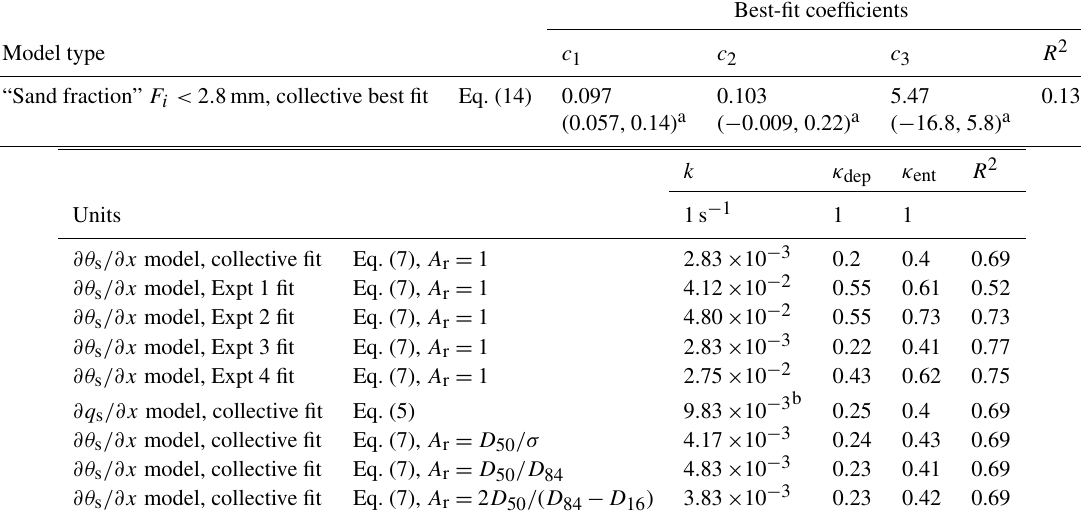
Best-fit coefficients